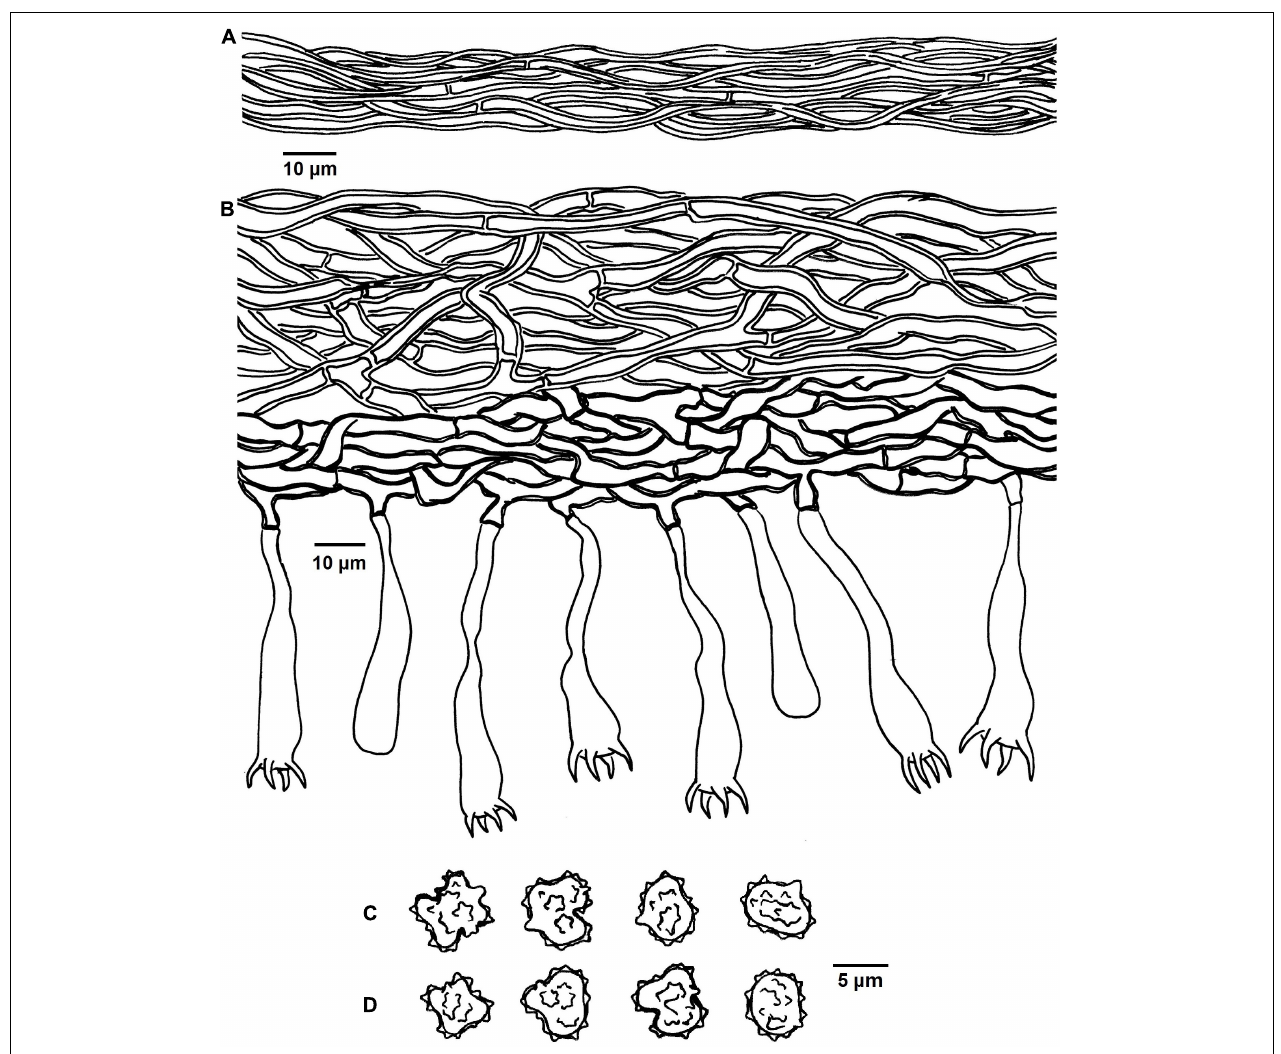
FIGURE 4 | Microscopic structures of Tomentella bidoupensis (drawn from holotype Yuan 12707). (A) Hyphae from a rhizomorph. (B) A section through basidiocarp. (C) Basidiospores in lateral view. (D) Basidiospores in frontal view.